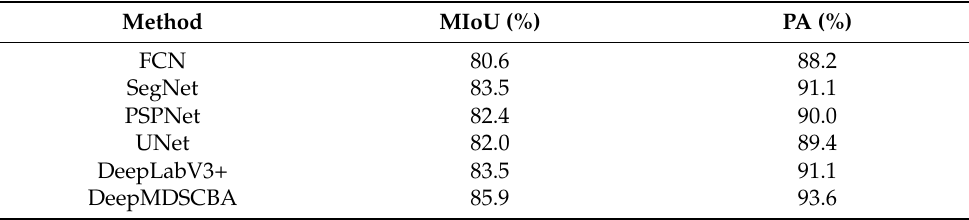
Table 14. Segmentation performance for apple images with an unseen